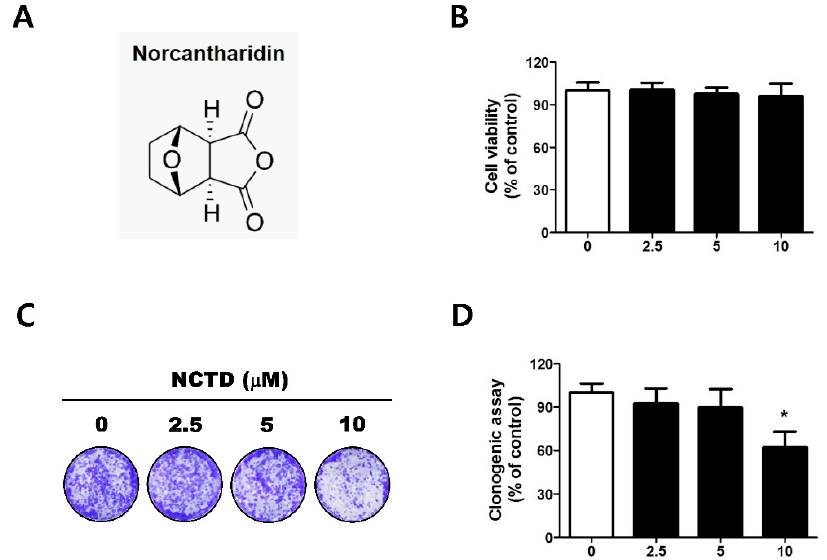
Figure 1. NCTD inhibits colony formation of YD-15 cells. ( A ) Chemical structure of NCTD. ( B ) Trypan blue exclusion assay for cell viability after the treatment of NCTD (2.5, 5, and 10 µ M) for 24 h. ( C , D ) Clonogenic assay for colony formation of YD-15 cells. Graphs show the mean ± SD of triplicate experiments and significance compared with the vehicle control (* p < 0.05).